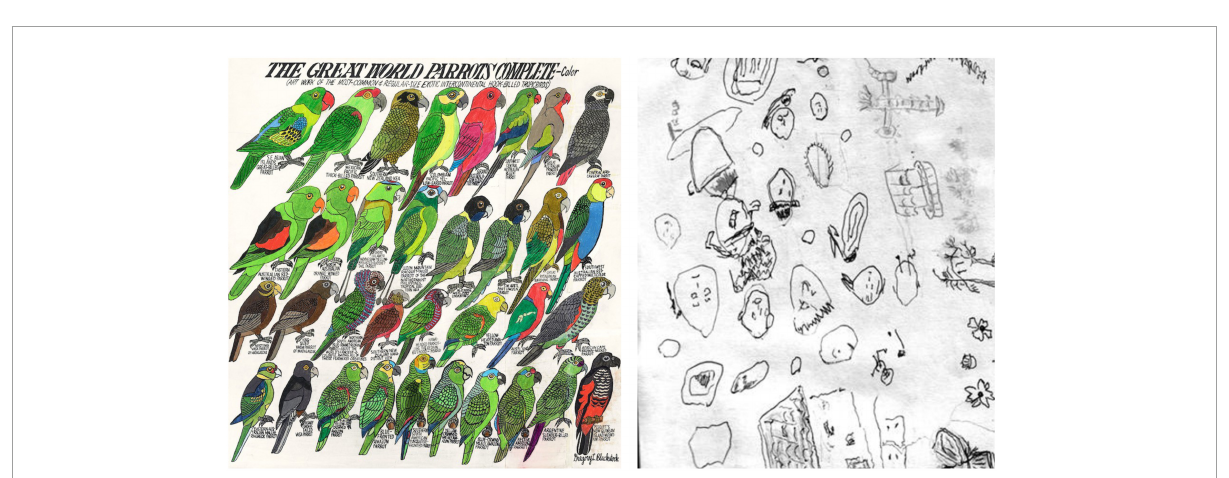
FIGURE3 (Left) Drawing by the Seattle artist Gregory Blackstock (Blackstock, 2006), whose extraordinary visual lists, while unique in their style, seem to convey a distinctive autistic cognitive mode (see also discussion in Roth, 2020) (reproduced with kind permission from the artist; courtesy Greg Kucera Gallery). (Right) Drawings of a PD patient with punding (Reproduced from O’Sullivan et al., 2007 with permission from BMJ Publishing Group Ltd.). Notice the creative use of visual likeness, repetition, and systematic modulation of objects. Small, repeating themes with slight variations suggest an apparent lack of generalization and overfitting to (random) variability, with many equally salient details, all seemingly deserving a category of their own (hyperspecific perceptual categories). Parallels may also exist with a published case report describing a graphic designer suffering from PD who obsessively created numerous variations of specific themes (Chatterjee et al., 2006; reviewed in Lauring et al., 2019a). Contrast the previous examples with the order, purity, regularity, repetition and control in the work of Yayoi Kusama (Ferrell, 2015), who expresses her experience of OCD, often employing polka dots, oblong organic shapes and infinity mirrors, with a conspicuous absence of systematic variation of details. Rather, these shapes represent grand categories with extensive symbolic weight, repeated ad infinitum (Ferrell, 2015) (Yayoi Kusama: “The Spirits of the Pumpkins Descended into the Heavens” (2017), National Gallery of Australia, Canberra, Australia; https://en.wikipedia.org/wiki/Yayoi_Kusama#/media/File:Kusama_Yayoi_The_Spirits_of_the_Pumpkins_Descended_into_the_Heavens.jpg). Further discussion in the